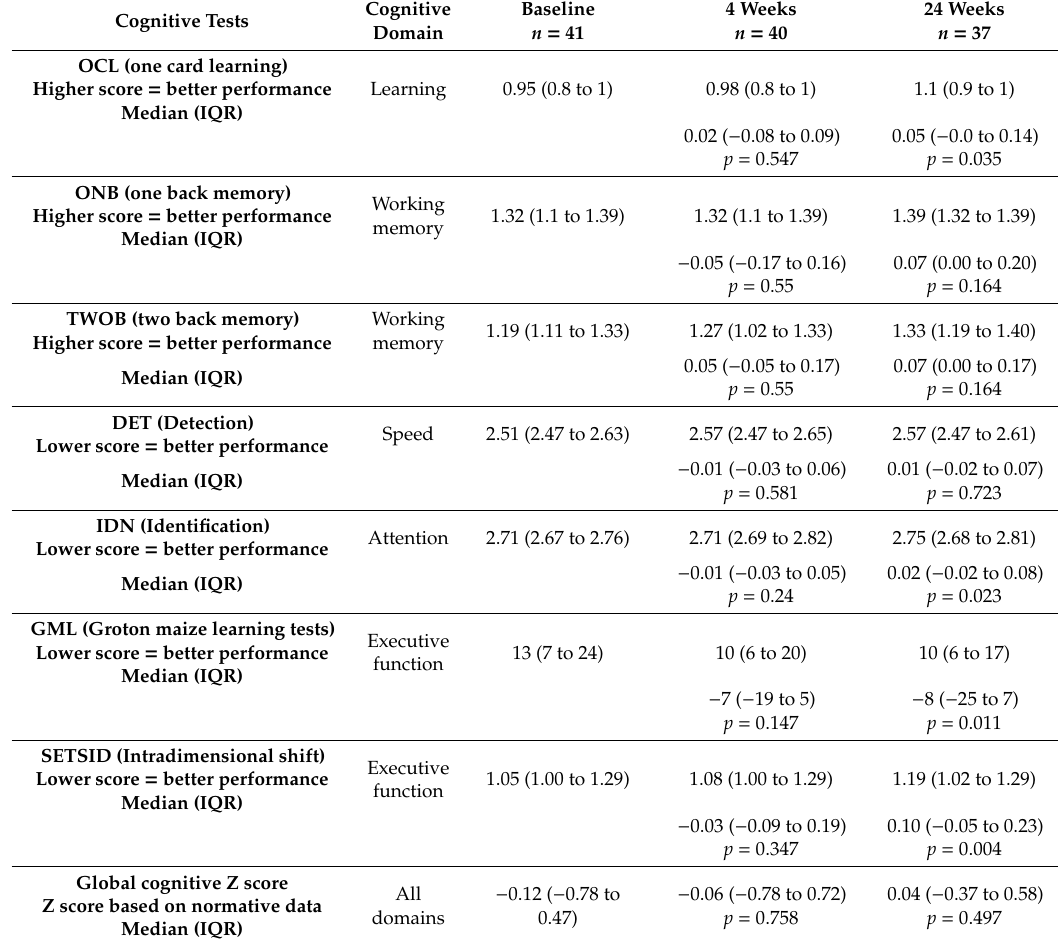
Table 3. Change in cognitive function 4 and 24 weeks after switching to Eviplera. P values correspond to the median change in absolute scores for all cognitive domains from baseline to week 4 and 24,